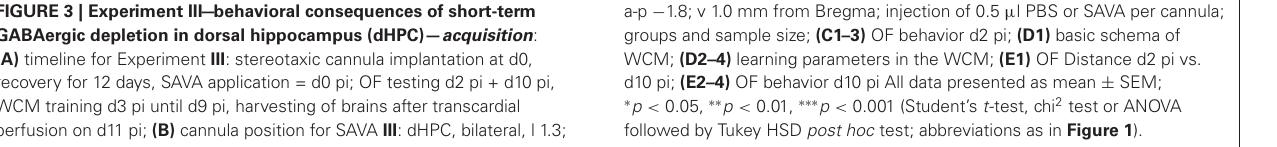
FIGURE 3 | Experiment III—behavioral consequences of short-term GABAergic depletion in dorsal hippocampus (dHPC)— acquisition : (A) timeline for Experiment III : stereotaxic cannula implantation at d0, recovery for 12 days, SAVA application = d0 pi; OF testing d2 pi + d10 pi, WCM training d3 pi until d9 pi, harvesting of brains after transcardial perfusion on d11 pi; (B) cannula position for SAVA III : dHPC, bilateral, l 1.3;